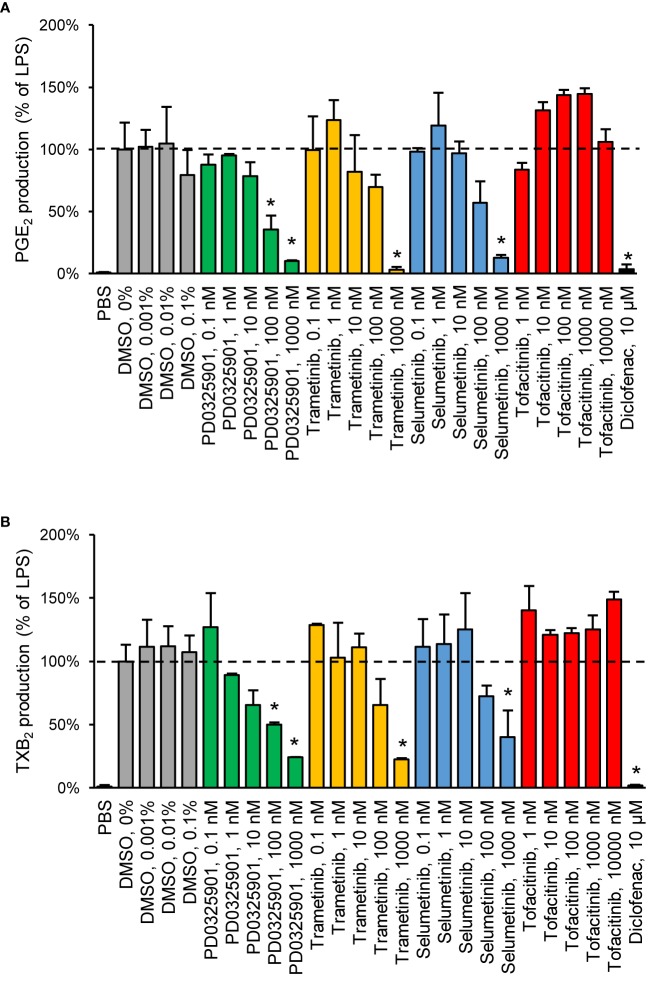
Validation of inhibitory effect on PGE2
(A) and TXB2
(B) production by MEK inhibitors in human whole blood. Diclofenac at 10 µM was used as positive control. Data are presented as mean ± SD of biological replicates (n = 2-6 per condition) from one representative experiment. The absolute prostanoid production in LPS control was 53.3 ± 8.3 ng/ml for PGE2 and 15.5 ± 2.1 ng/ml for TXB2. The concentration–response was tested in two donors. Statistical significance was tested using two-sample t-test with Bonferroni correction (p < 0.05). The asterisk (*) represents statistical significance to vehicle control.